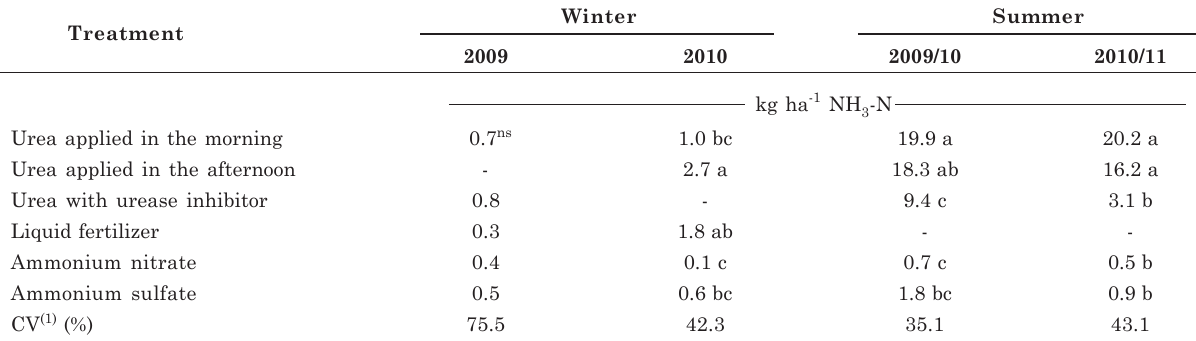
(1) Coefficient of variation. Means followed by different letters in the column differ by the Tukey test at 5 %. ns not significant.